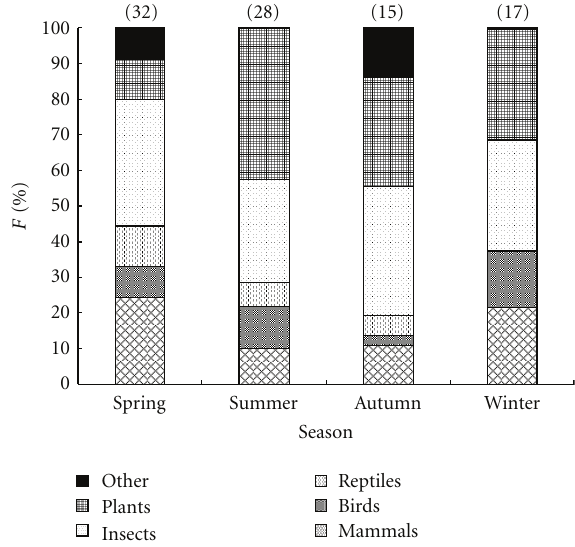
Figure 1: Seasonal percentage of frequency of occurrence (%F) of prey groups in the stone marten diet, in Central Greece during 2003–2006. Numbers above columns are sample